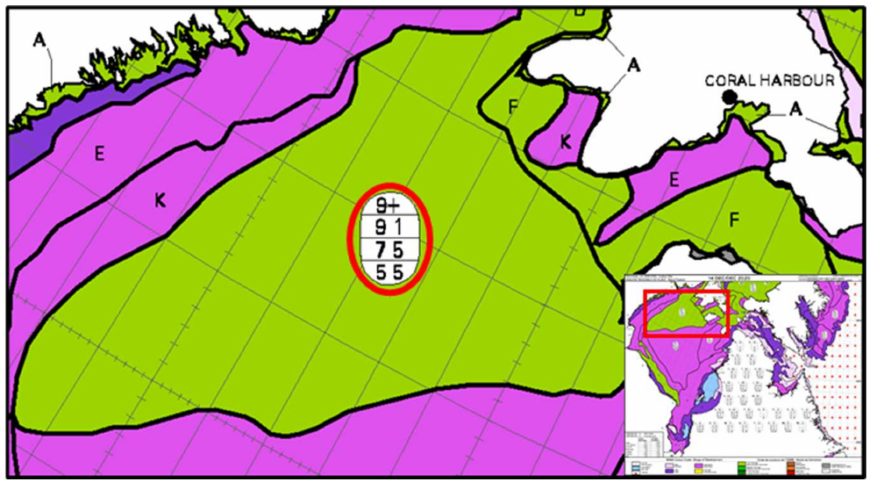
Figure 2. The weekly ice chart of Hudson Bay published by CIS on 14 December 2020. The ice egg circled in red indicates that more than 90% of the area is occupied by ice, and the ThinFI (code 7) with the proportion of 90% of the total ice is